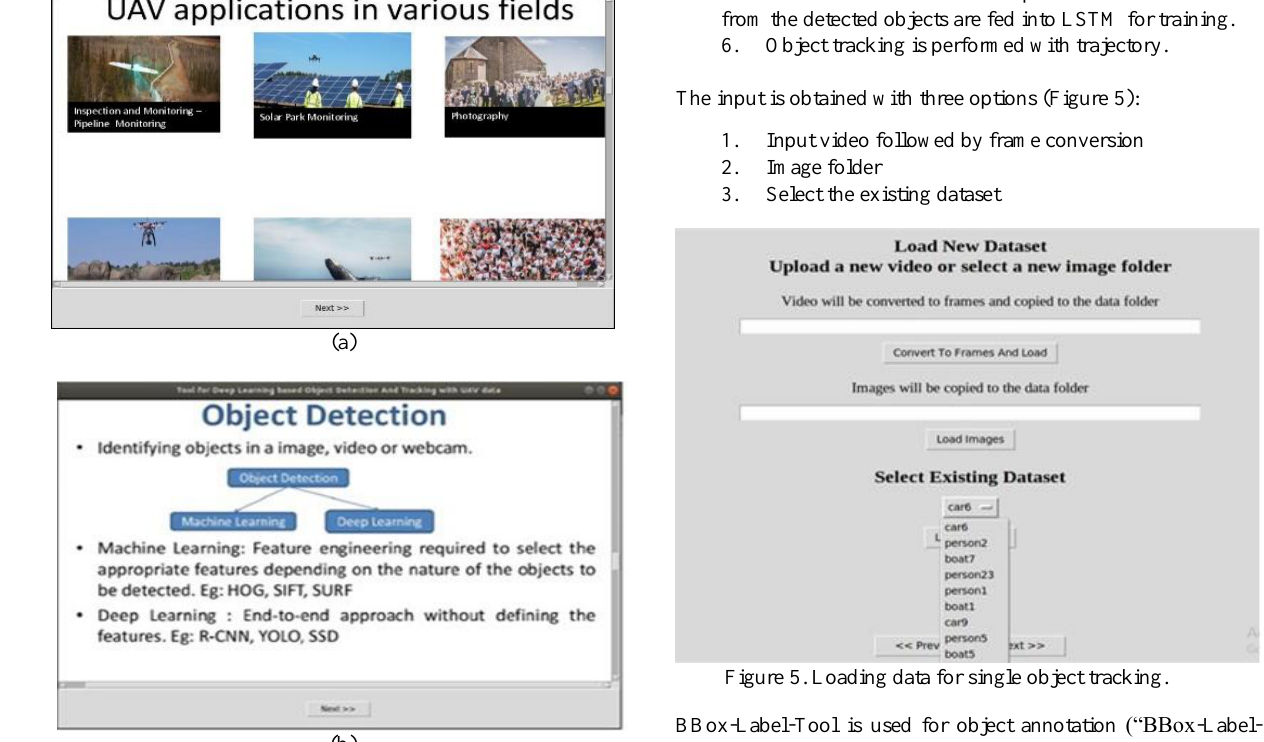
Figure 3(a) and (b). Sample of study resource in DL-ODT-UAV tool